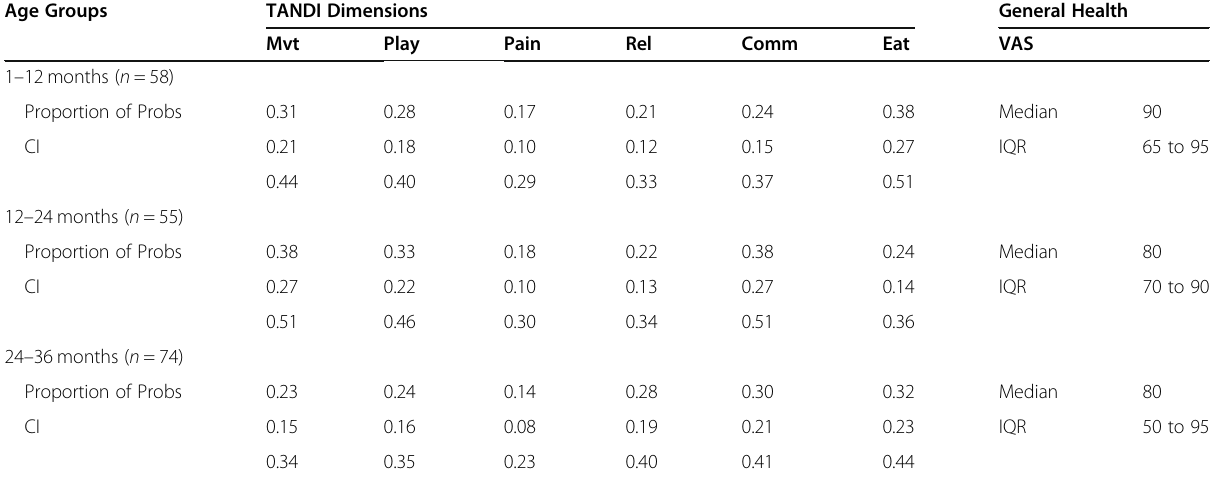
Table 4 Proportion of Problems Reported for TANDI dimensions for all children per age group Age Groups TANDI